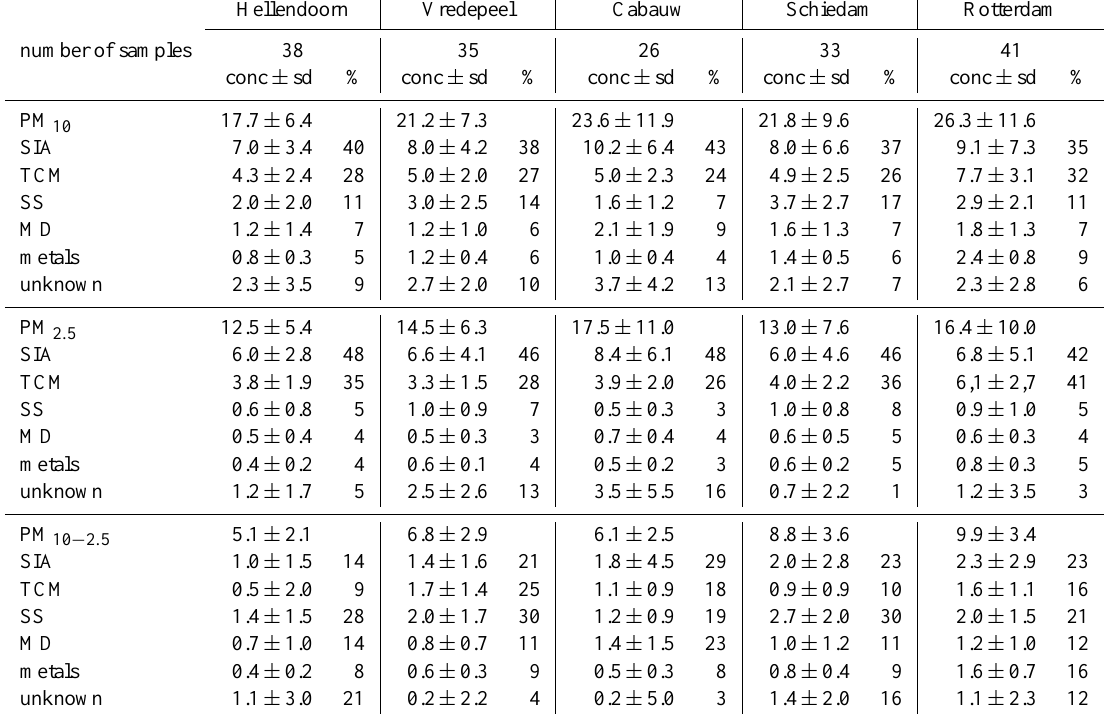
Table 4. Concentrations of the constituents as determined in the PM 10 and PM 2 . 5 data set for the five